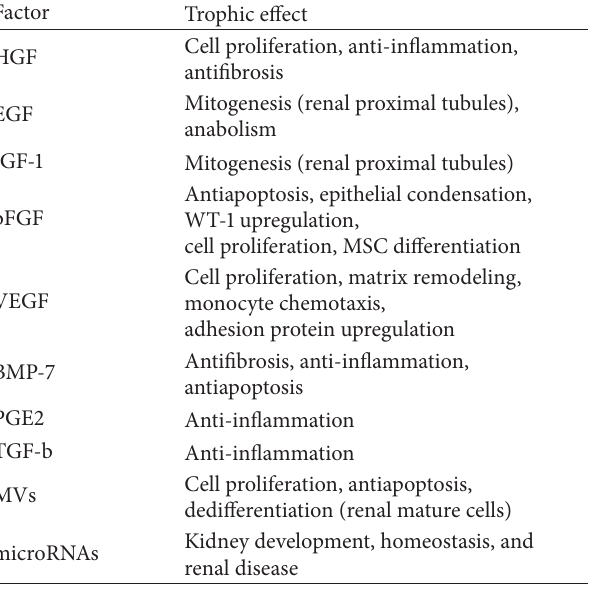
Table 2: Summary of the adult kidney stem